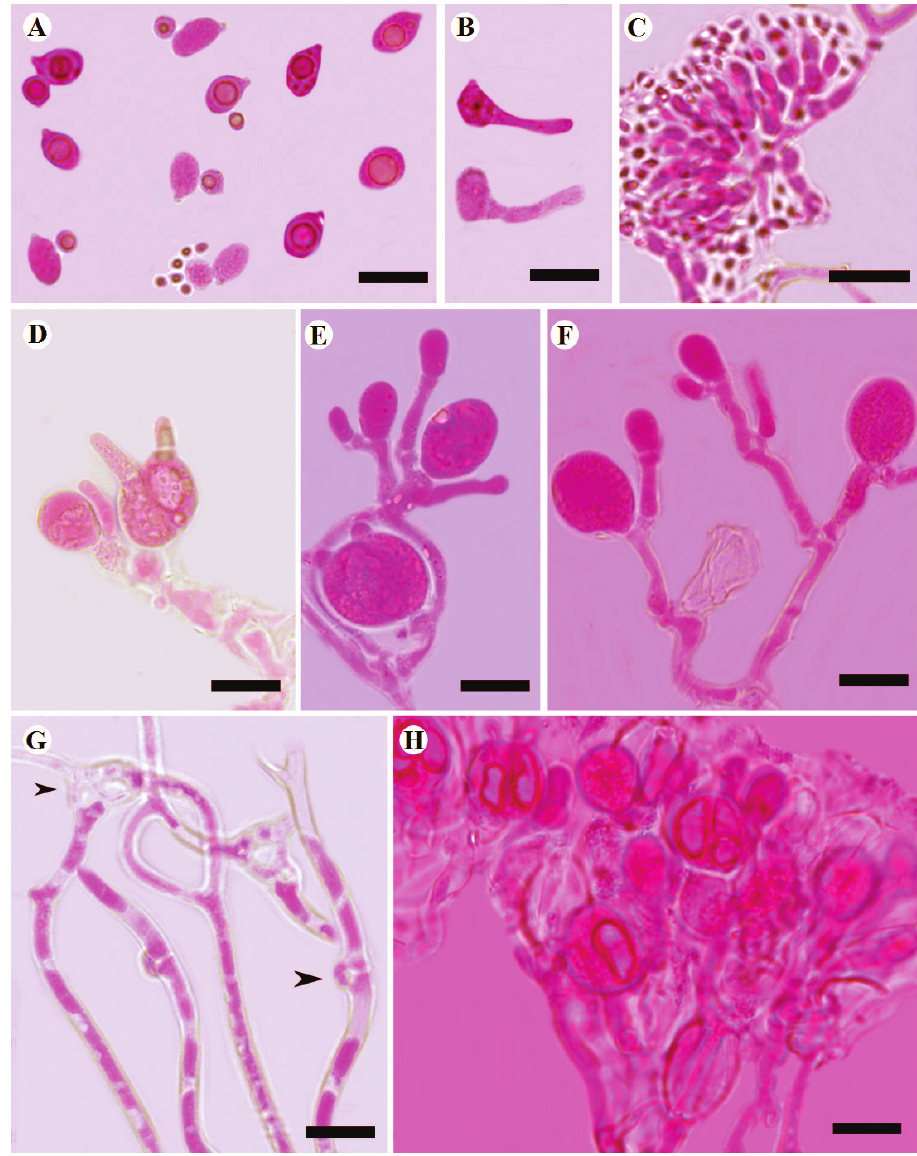
Figure 9. Microscopic structures of Tremella subfibulifera (Alvarenga 334) A basidiospores and secondary spores B germination tubes of basidiospores C conidia and conidiophores D–F basidia and probasidia G hy- phae with clamp connections and clamp complexes H a section of hymenium. Scale bars: 10 µm ( A–H ).